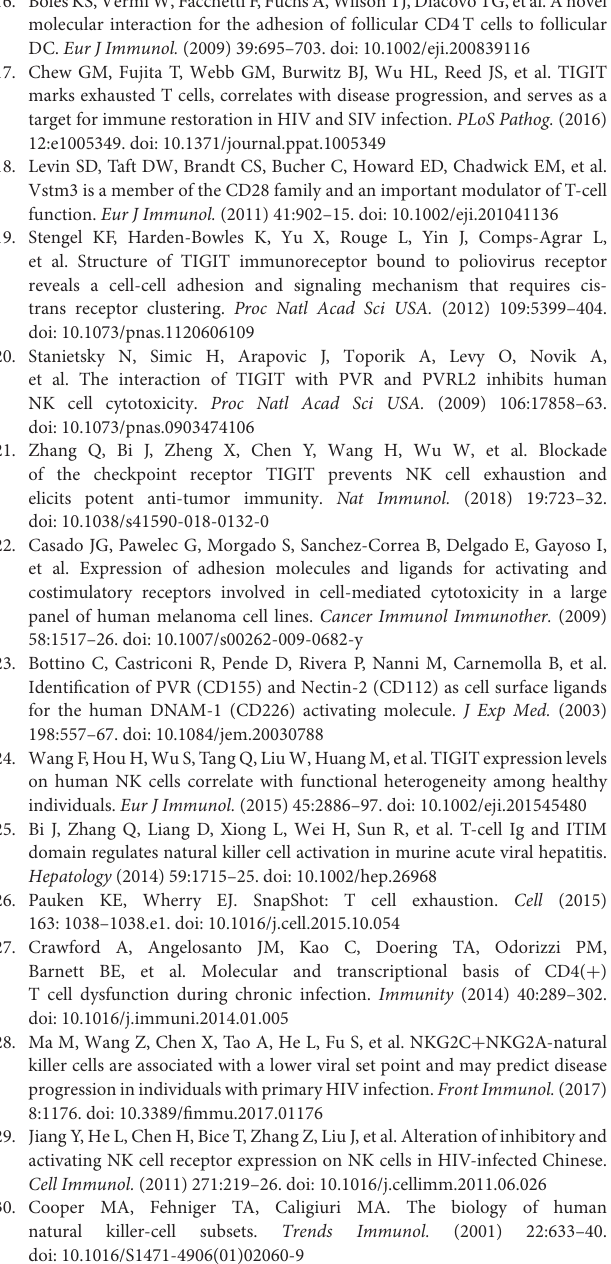
Figure S3 | The expression of TIGIT on NK cell subsets and correlation with the CD4 + T cell counts. (A) Representative flow cytometry plots showing the percentages of TIGIT on four NK cell subsets (CD3 − CD56 bright CD16 − / + , CD3 − CD56 dim CD16 + , CD3 − CD56 dim CD16 − , and CD3 − CD56 − CD16 + ) in the HC and HIV groups. The expression of TIGIT was gated according to an isotype control. (B) Comparisons of the percentages of TIGIT expression among different NK cell subsets in the HC group ( n = 26). (C) Comparisons of the percentage of TIGIT expression among different NK cell subsets in the HIV-infected group ( n = 38). (D) Comparisons of the percentages of TIGIT on different NK cell subsets between HC ( n = 26) and HIV-infected ( n = 38) groups. (E) Analysis of the correlation between TIGIT expression on CD56 − CD16 + NK cells and